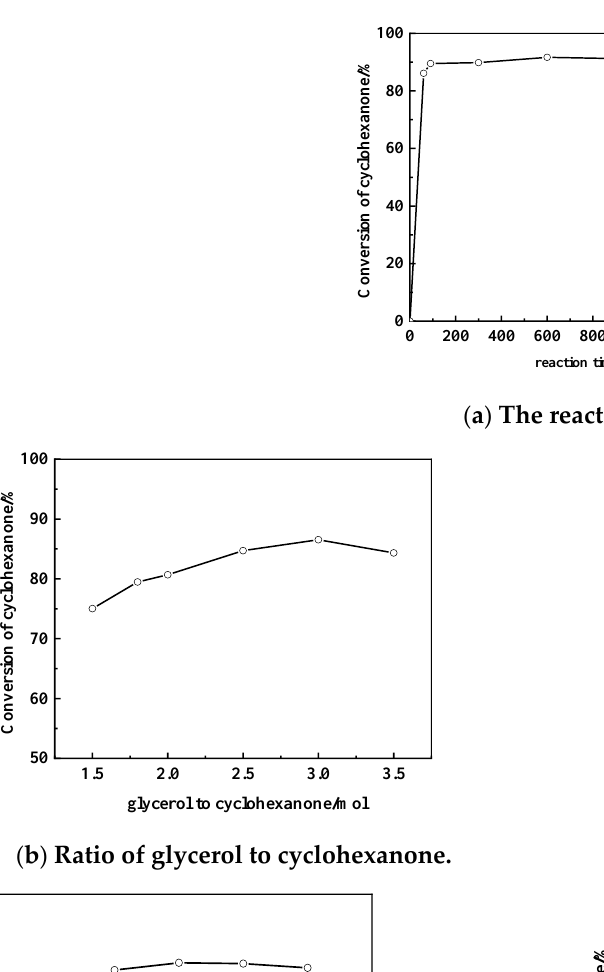
( b ) Ratio of glycerol to cyclohexanone. ( c ) The catalyst loading.